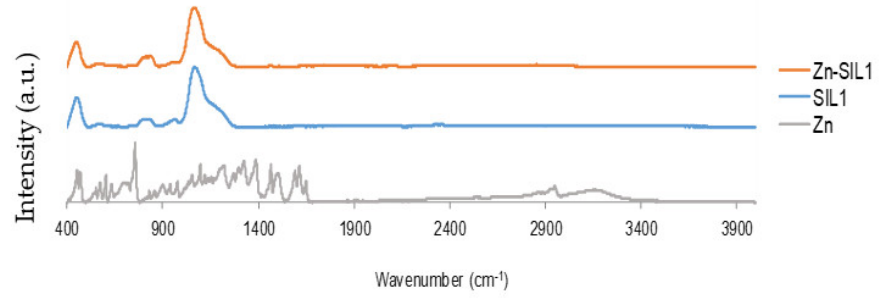
Figure 3. Infrared spectra of pure Zn(II)-AHBD catalyst (Zn) and silica aerogels: blank silica aerogel (SIL1) and Zn(II)-AHBD-impregnated aerogel (Zn-SIL1).